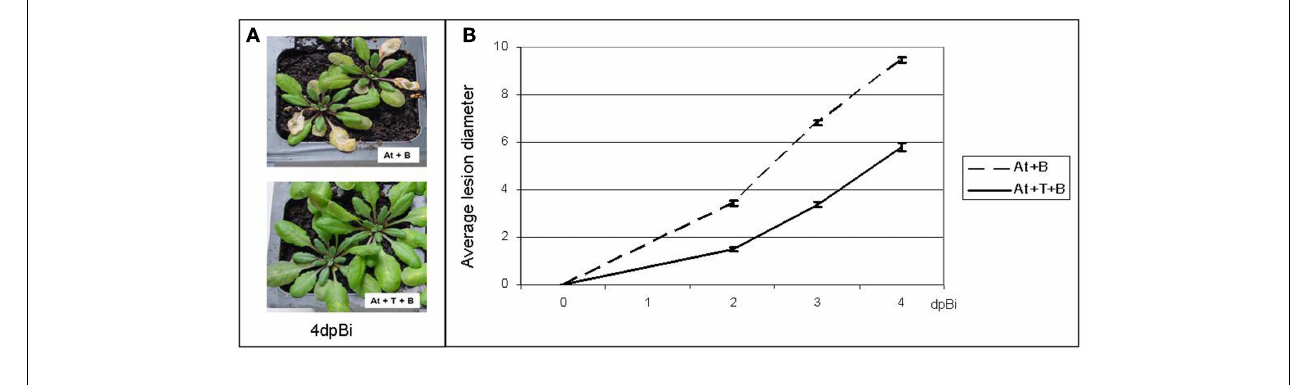
average lesion diameters on 2, 3, and 4days post-inoculation (dpBi) with B. cinerea on plants treated with T. hamatum T382 (solid line) and mock-treated control plants (dashed line).The disease assay was repeated 12 times comprising a total of 2000 plants. Confidence intervals (95%) are shown.